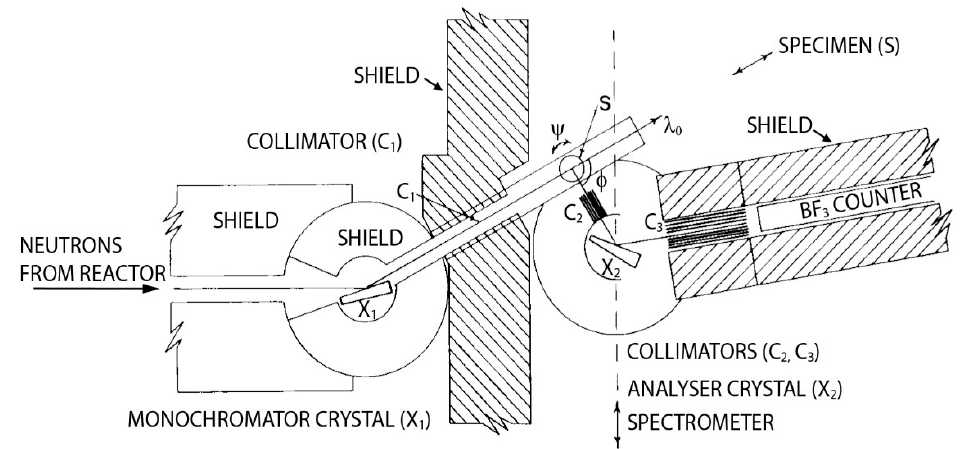
Figure 2. The first crude version of the triple-axis spectrometer. Monoenergetic neutrons are selected by the large single-crystal monochromator (X 1 ) and impinge on the specimen (S), which is located on a table whose orientation ( ψ ) with respect to the incident beam can be selected. This table can be moved along the incident beam as desired. The analyzing spectrometer, which employs crystal X 2 , is a diffractometer of especially large aperture that can be translated as a unit; the angle, Φ , through which the examined neutrons are scattered is determined by triangulation. This figure is taken from Figure 3 of ref. [2] and modified to label the collimators C 2 and C 3 , the monochromator X 1 and analyzer X 2 . Copyright by the American Physical Society.